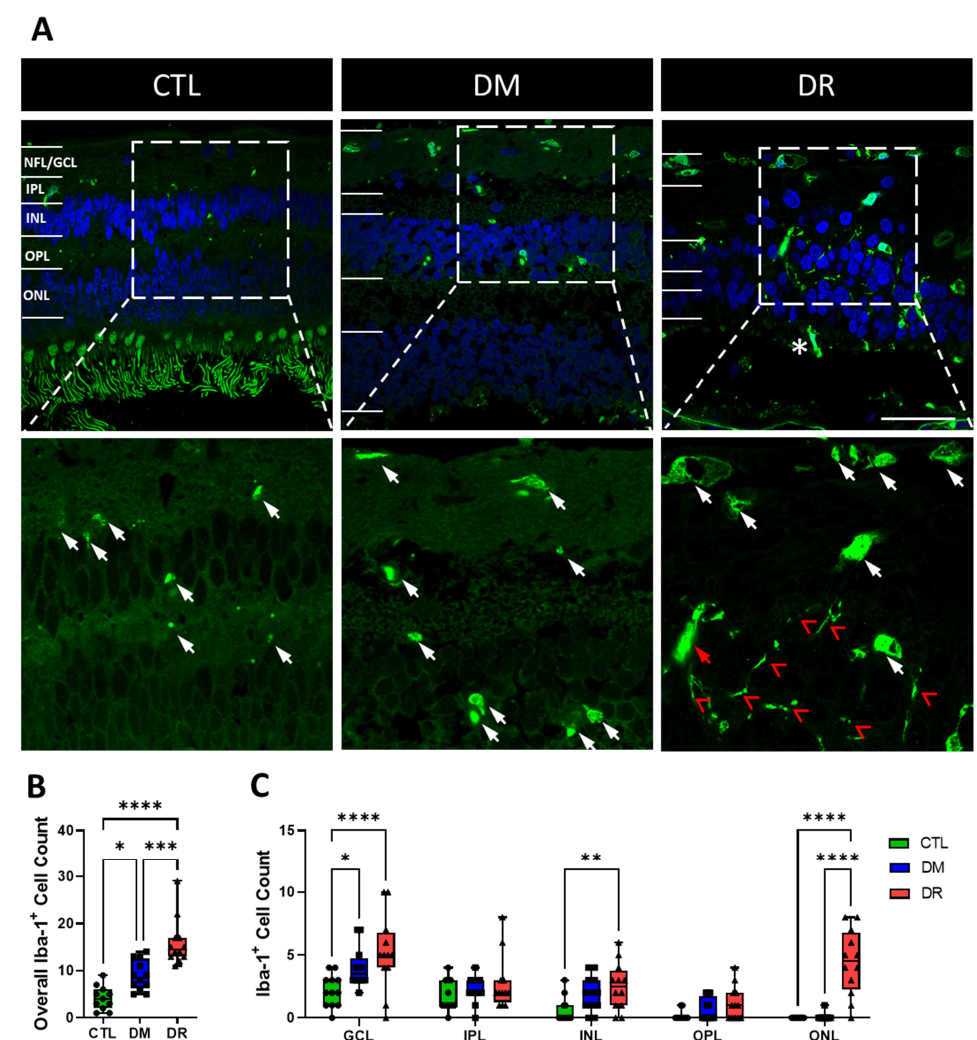
Figure 3. Iba1 + cells increased in number and size and migrated more frequently towards the ONL comparing CTL to DM to DR. ( A ) Immunohistochemical images showing the increased number and size of Iba-1 + cells (green, white arrows) from CTL to DM to DR. Iba-1 + cells in CTL and DM remained within the NFL/GCL, IPL and INL, but invaded into the ONL in DR, becoming rod-like (red arrow) and displaying long, branched dendrites (red arrowheads), while some were found in the subretinal space (asterisk) between photoreceptors and RPE. ( B ) Iba-1 + cell count in the entire retina was significantly higher in DM compared to CTL ( p ≤ 0.05), and significantly higher in DR compared to CTL ( p ≤ 0.0001) and DM ( p ≤ 0.001). ( C ) Iba-1 + cell count quantified by each retinal layer showed that in the GCL, Iba-1 + cell count was significantly higher in DM ( p ≤ 0.05) and DR ( p ≤ 0.0001) compared to CTL. In the INL, Iba-1 + cell count was higher in DM compared to CTL but without significant difference, while the cell count was significantly higher in DR compared to CTL ( p ≤ 0.01). In the ONL, Iba-1 + cell count was significantly higher in DR compared to CTL ( p ≤ 0.0001) and DM ( p ≤ 0.0001). Iba-1 + cell count in the IPL and OPL was low and showed no significant difference between CTL, DM and DR. Insets of immunohistochemical images are presented in the bottom row at 2 × magnification of the top row. Scale bar = 50 µ m. Statistical analysis was carried out using one-way ANOVA for expression in the entire retina and two-way ANOVA for expression in each retinal layer. * p ≤ 0.05; ** p ≤ 0.01; *** p ≤ 0.001; **** p ≤ 0.0001. Data point of each patient in CTL, DM and DR are marked as circle, square and triangle,